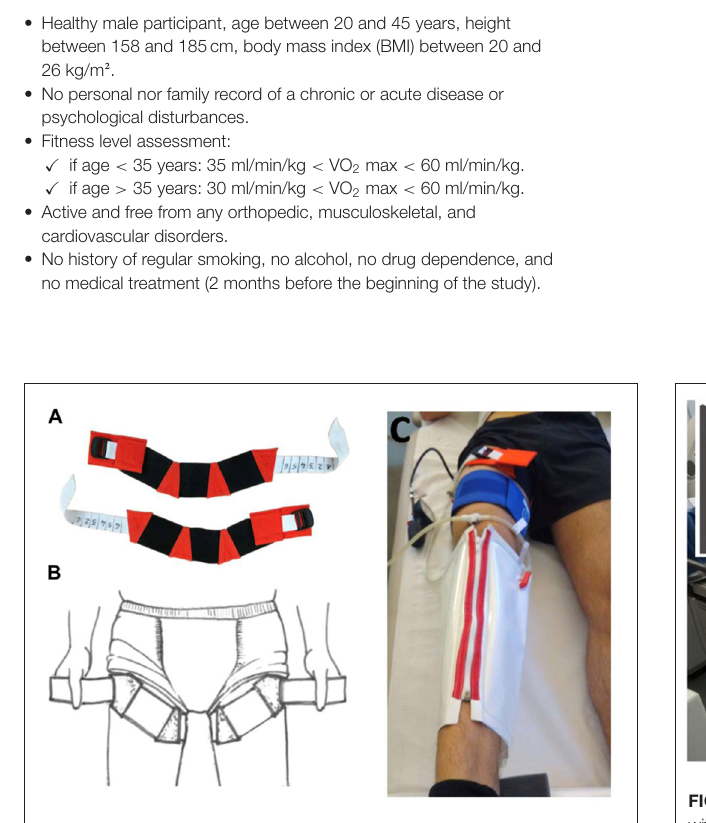
FIGURE 1 | Venoconstrictive thigh cuffs (VTC) countermeasure (photo MEDES). (A) Venoconstrictive thigh cuffs are elastic strips, adjustable to the size of the thigh with clamping segment (white segment). (B) VTC are worn on the upper part of the thigh. (C) Individual adjustment of VTC with plethysmography to apply a 30 mmHg pressure on the upper thigh and performed at BDC-2.